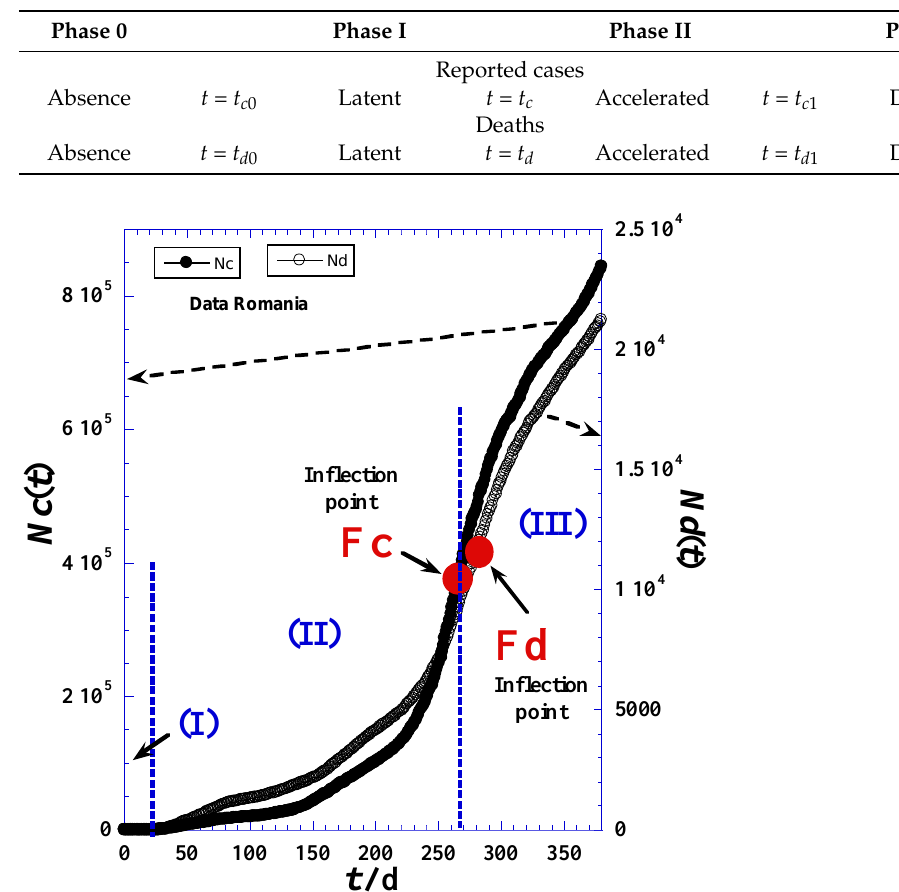
Table 1. Different spread phases and identification of the accelerated phase for the reported cases and deaths.